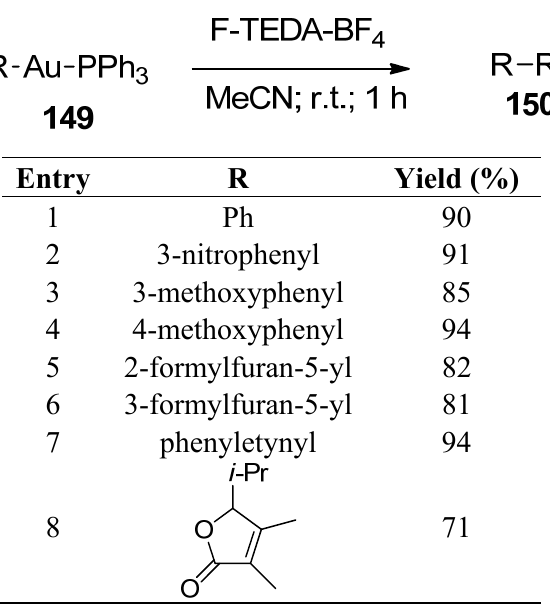
Table 15. Homocoupling reactions of organogold(I) triphenylphosphane compounds induced by F-TEDA-BF 4